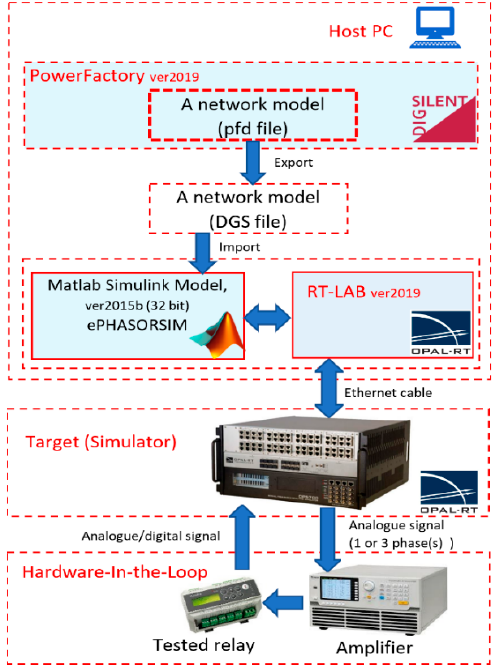
Figure 7. Interconnections between PowerFactory, ePHASORSIM, RT-lab, Target, amplifier, and relay.